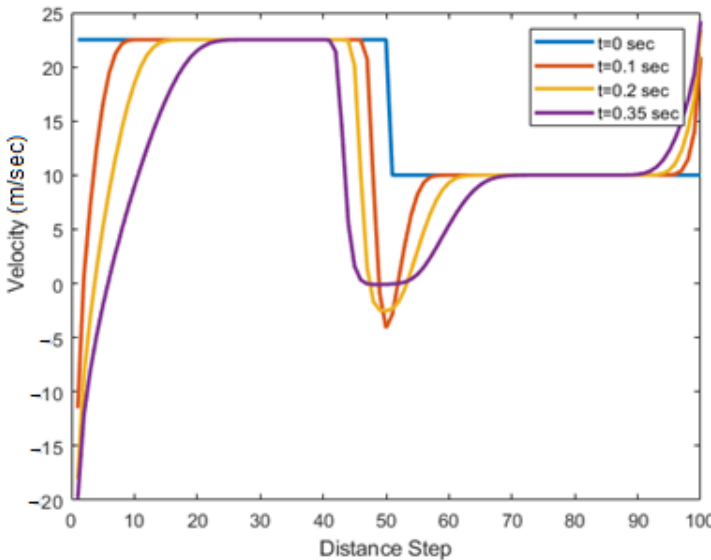
Figure 10. Velocity behavior of PW model on straight road with no ingress traffic.